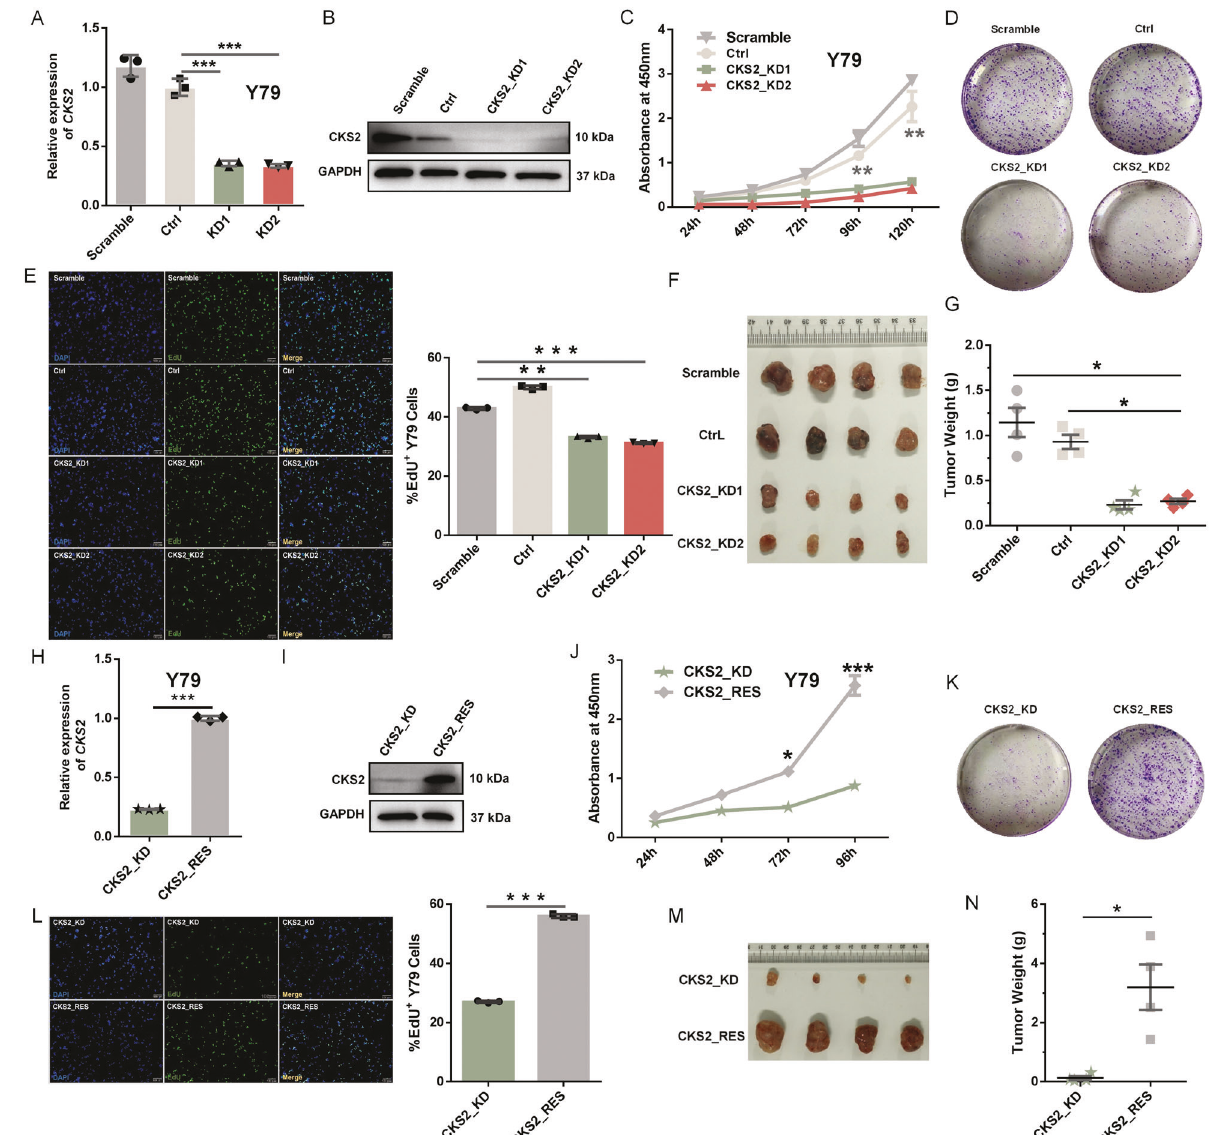
(CKS2_KD1 and CKS2_KD2). Right panel: Quanti fi cation of percent EdU + cells, shown as mean ± SEM, ** p < 0.01, *** p < 0.001, ( n ≥ 3). F, G Tumor xenografts using Y79 cells in CKS2 knockdown groups ( CKS2 _KD1 and CKS2_KD2) were smaller than without CKS2-KD groups